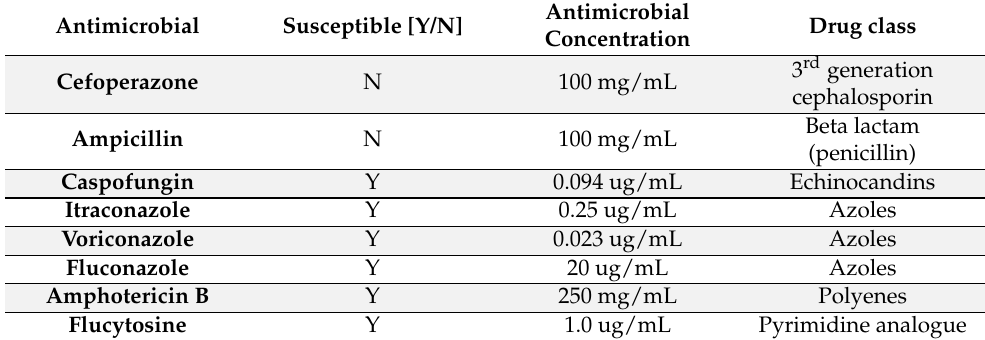
Table 2. Antifungal susceptibility.